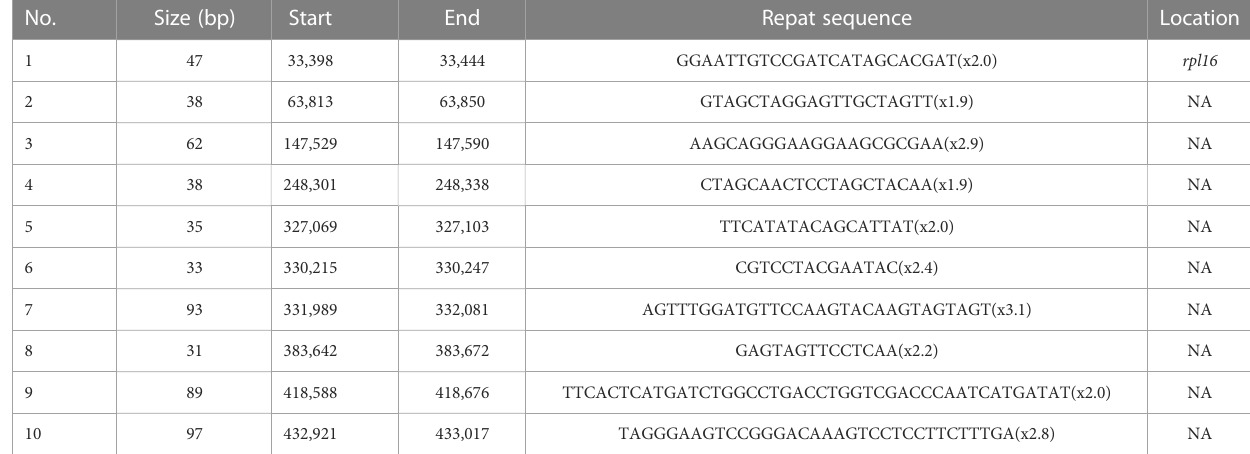
TABLE 3 Characteristics distribution of perfect tandem repeats in A. of fi cinalis mitochondrial genome.